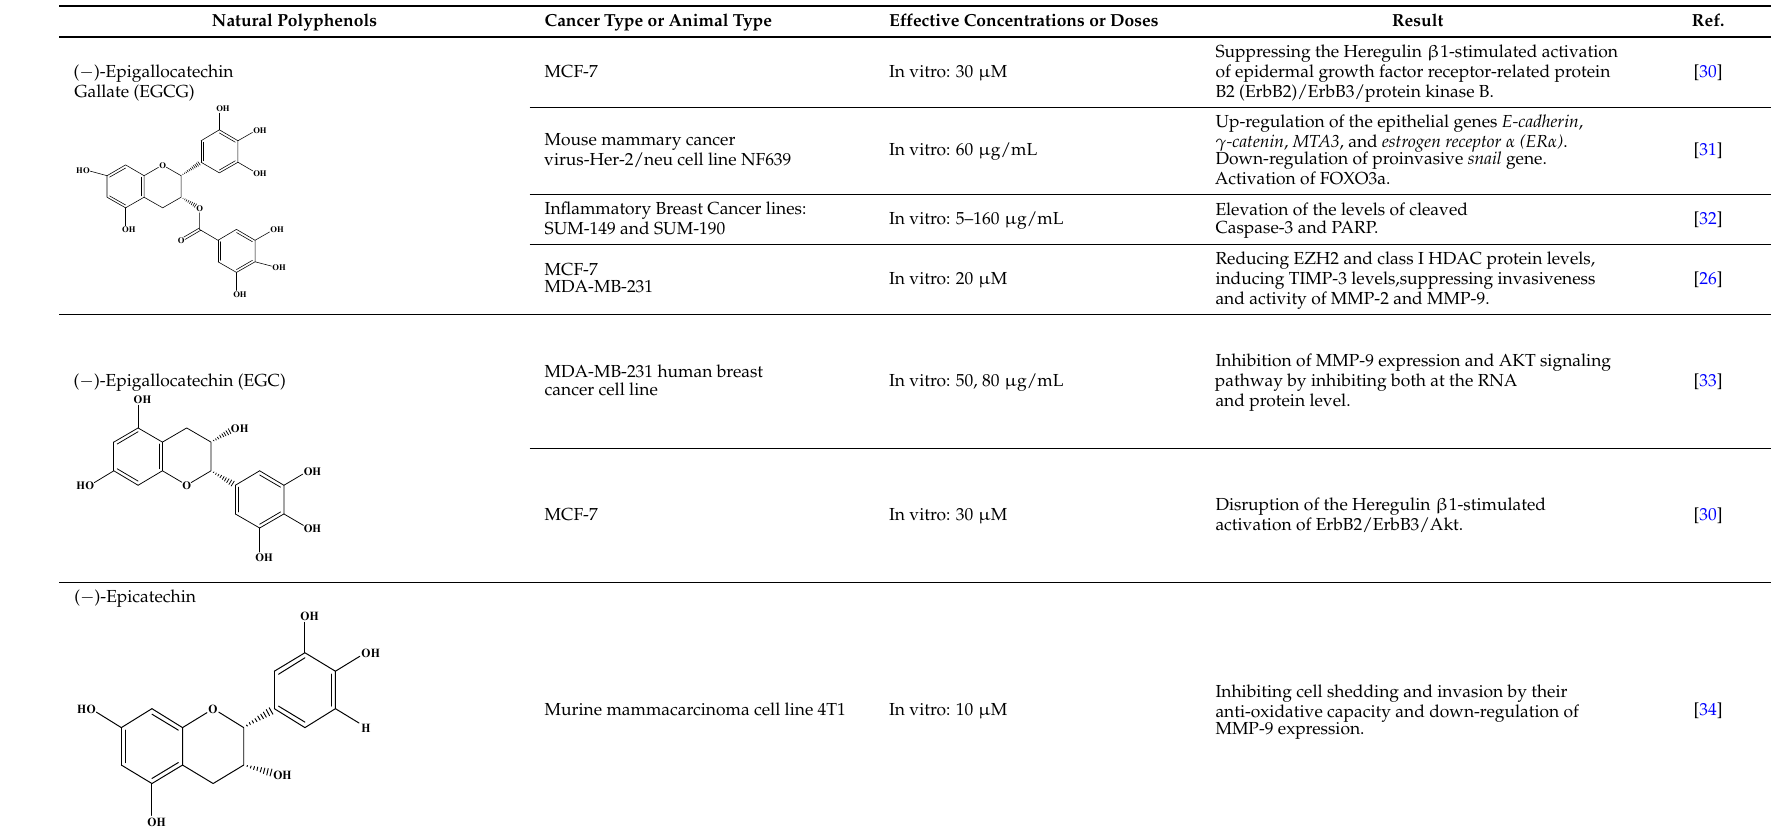
Table 1. Mechanisms of natural polyphenols interfering in breast cancer metastasis.